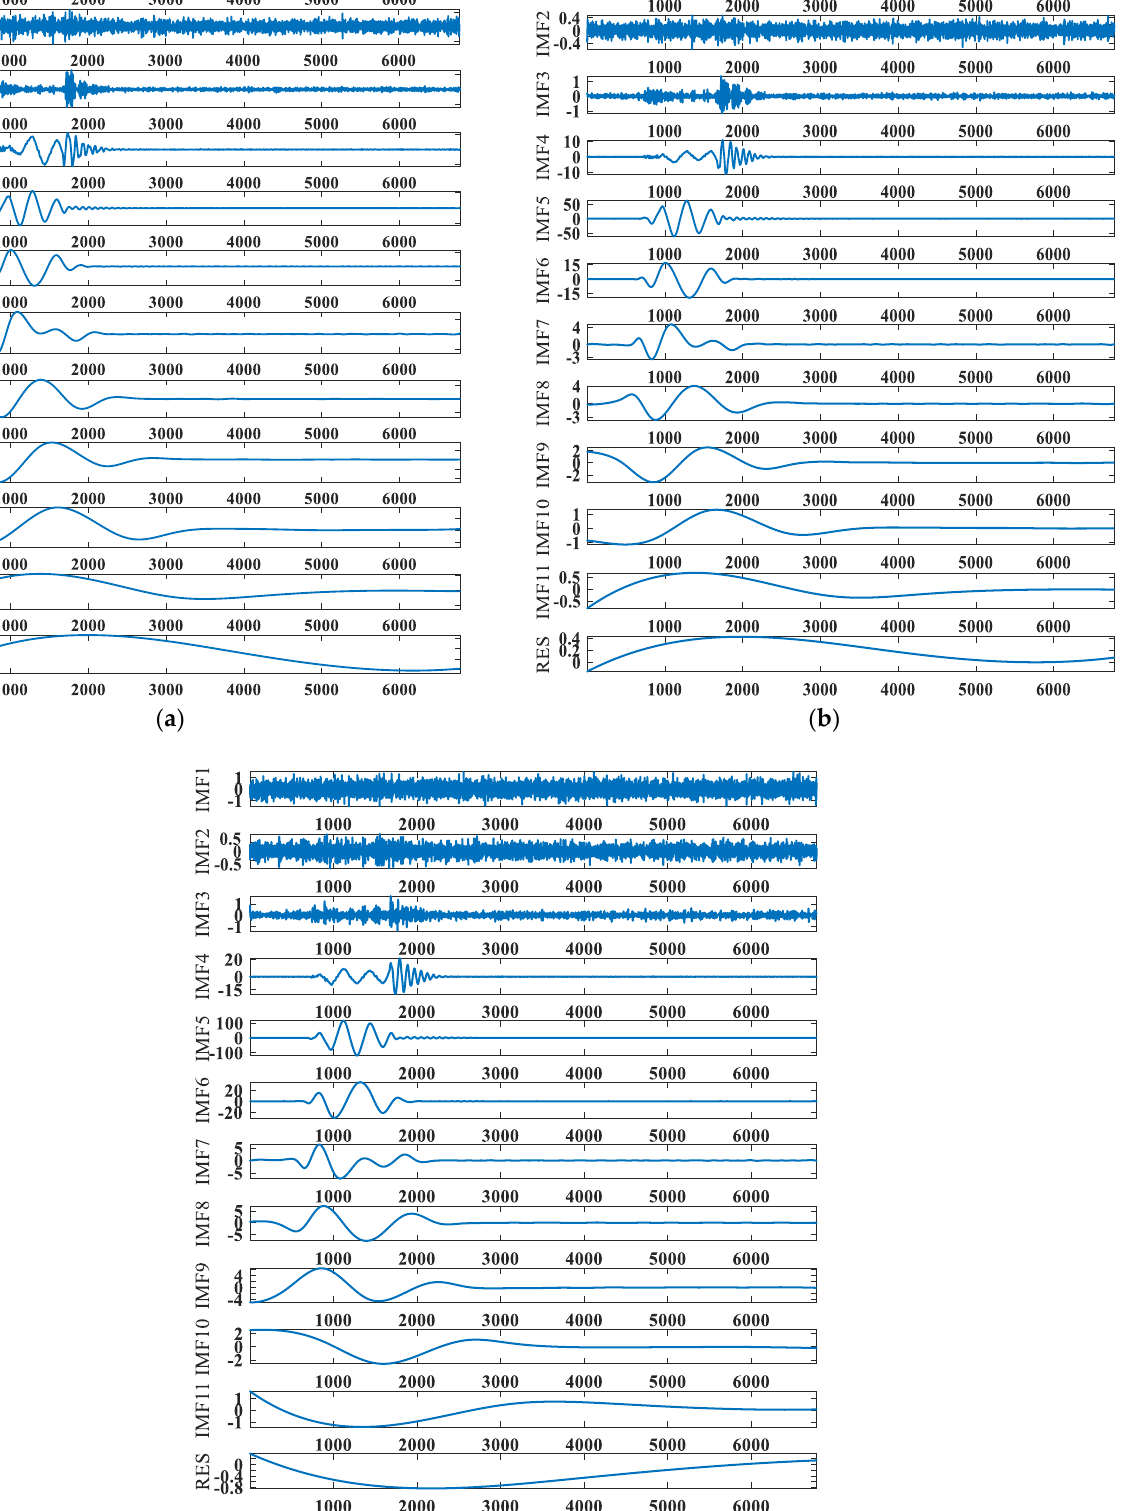
Figure 6. ( a ) Line 1 of the EEMD decomposition diagram. ( b ) Line 2 of the EEMD decomposition diagram. ( c ) Line 3 of the EEMD decomposition diagram. The sample entropy values calculated for each line are shown in Table 1. Table 1. Sample entropy values for different line components.